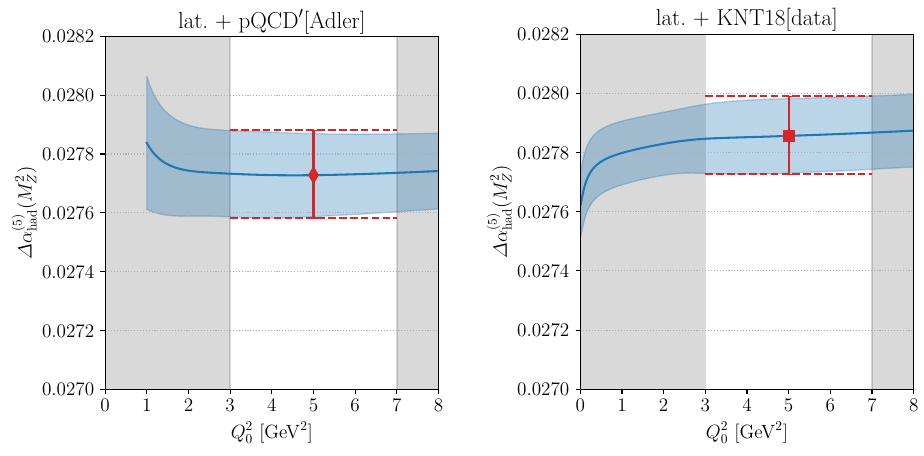
Figure 13 . The hadronic contribution to the running coupling for five flavors at the Z pole (cid:0) (cid:1) mass, ∆α (5) M 2 , evaluated according to eq. (5.1) and using our lattice result for ∆α (5) Z had plotted as a function of the threshold energy Q 2 (cid:0) (cid:1) (cid:0) (cid:1) [ ∆α (5) − M 2 − ∆α (5) − Q 2 ] computed via the pQCD 0 approach in eq. (5.2) using the pQCDAdler 0 Z had had software package [141]. Right: results based on the KNT18[data] approach of eq. (5.3) using the R -ratio data with full covariance matrix [31, 138]. The red symbols in each panel are taken to produce the final estimates for each method, while the maxima and minima of the blue bands within the non-shaded region are used to estimate the